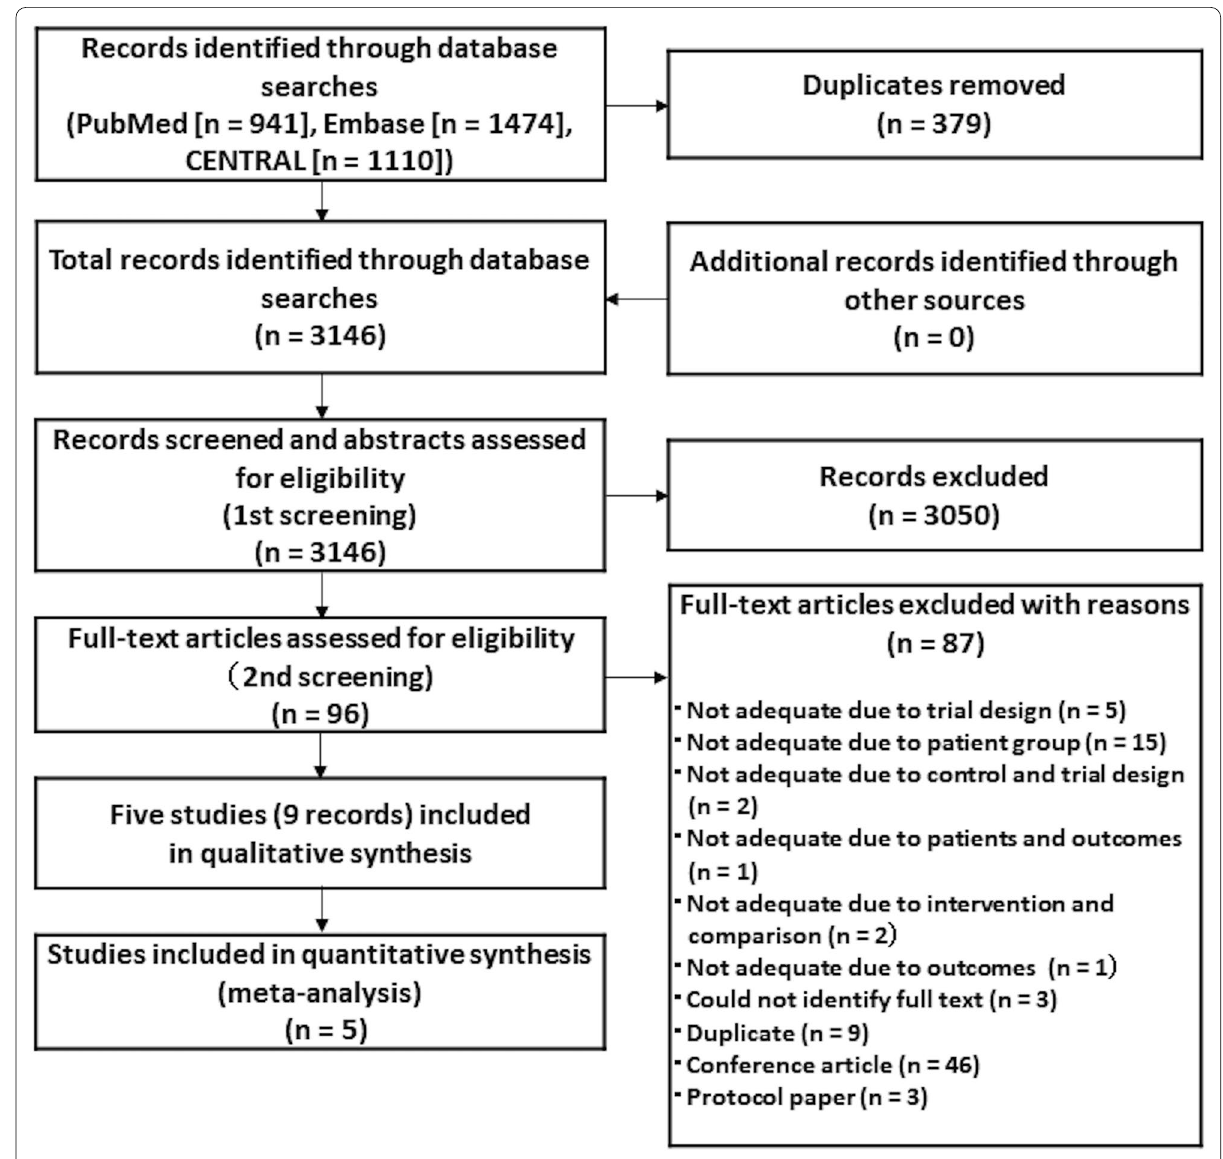
Fig. 1 Flowchart of the study selection